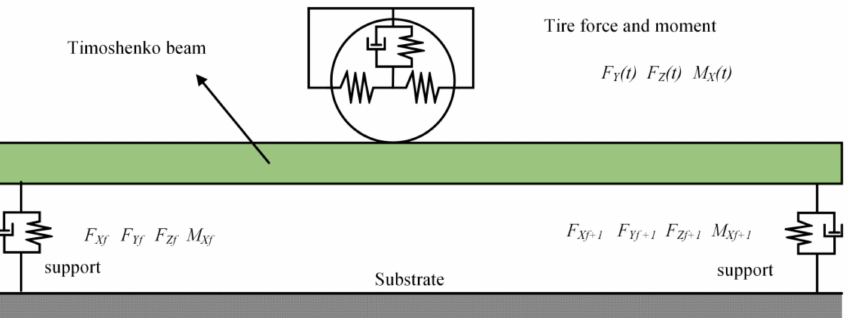
Figure 6. Dynamic model of flexible track beam